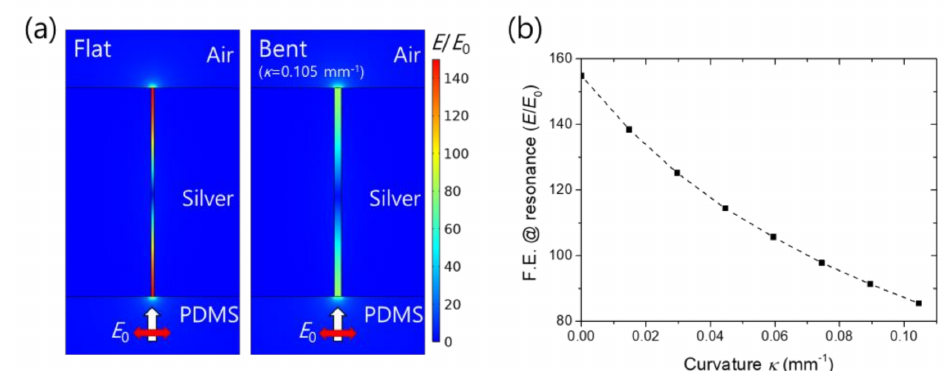
Figure 4. Field enhancement modulation: ( a ) Electric field distributions in the vicinity of a slit for the flat and bent ( κ = 0.105 mm − 1 ) cases at their respective resonances. The white and red arrows denote the light incident direction and polarization, respectively. The electric fields were normalized by the incident field E 0 ; ( b ) Field enhancement factor ( E / E 0 ) at the resonance as a function of the curvature. Average values were taken at the top